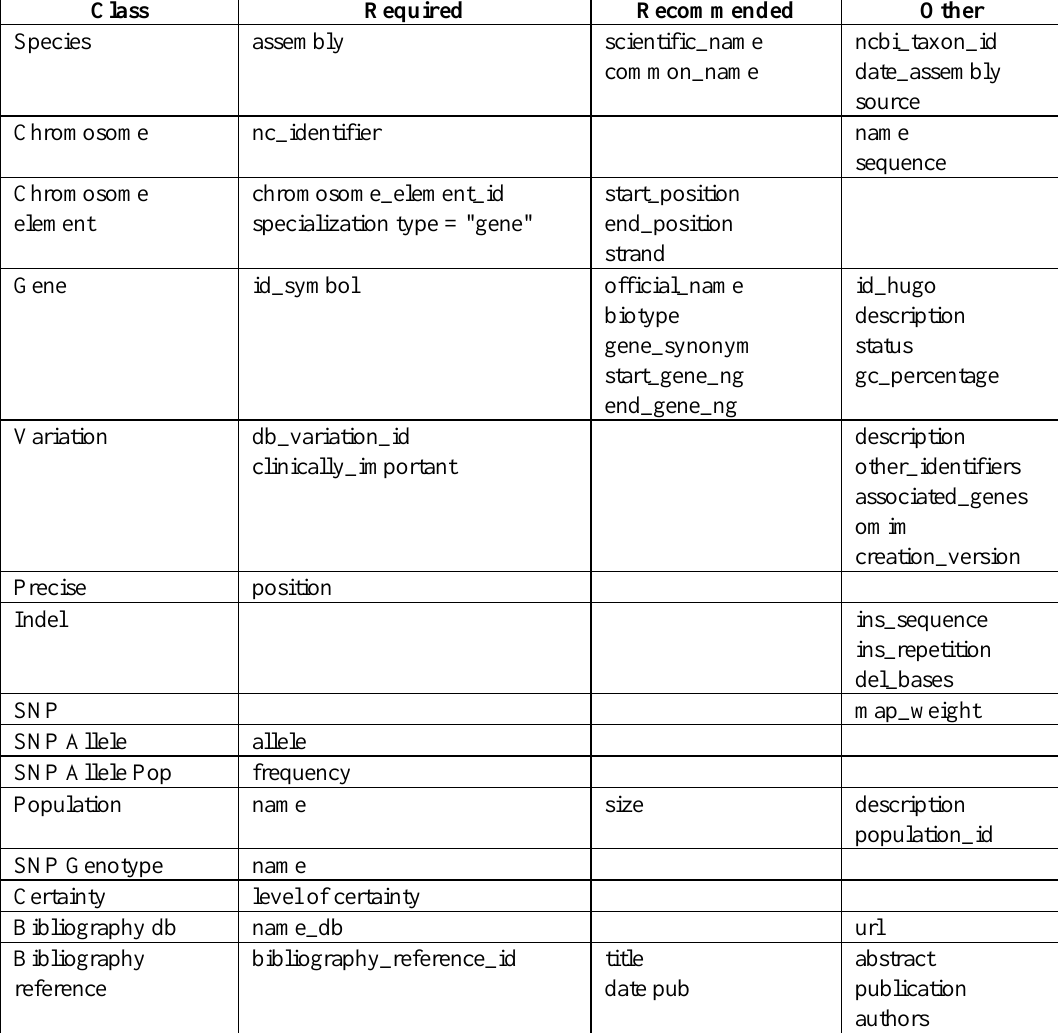
Table 2. Classification of the attributes of the CSHG according to completeness